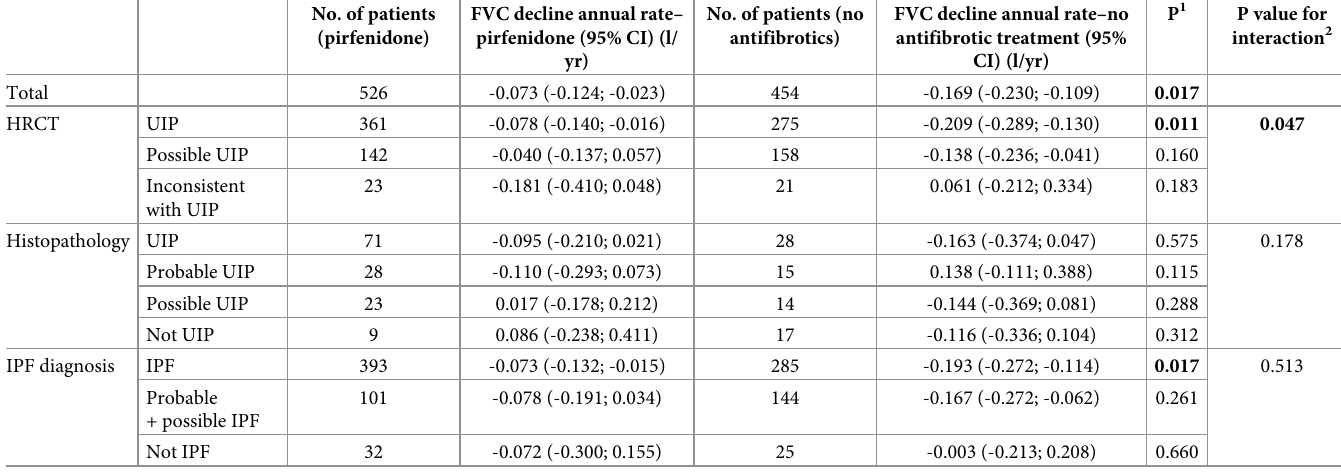
1 difference pirfenidone vs no antifibrotic treatment 2 differential effect of pirfenidone between diagnostic subgroups; higher P value (above 0.05) indicates that the possible effect of pirfenidone therapy (a difference between pirfenidone and no antifibrotic treatment) is similar across all diagnostic